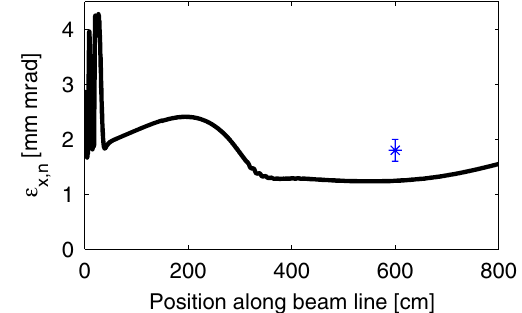
FIG. 8. Simulation of the emittance evolution in PARMELA . The point with error bars indicates the emittance as measured at